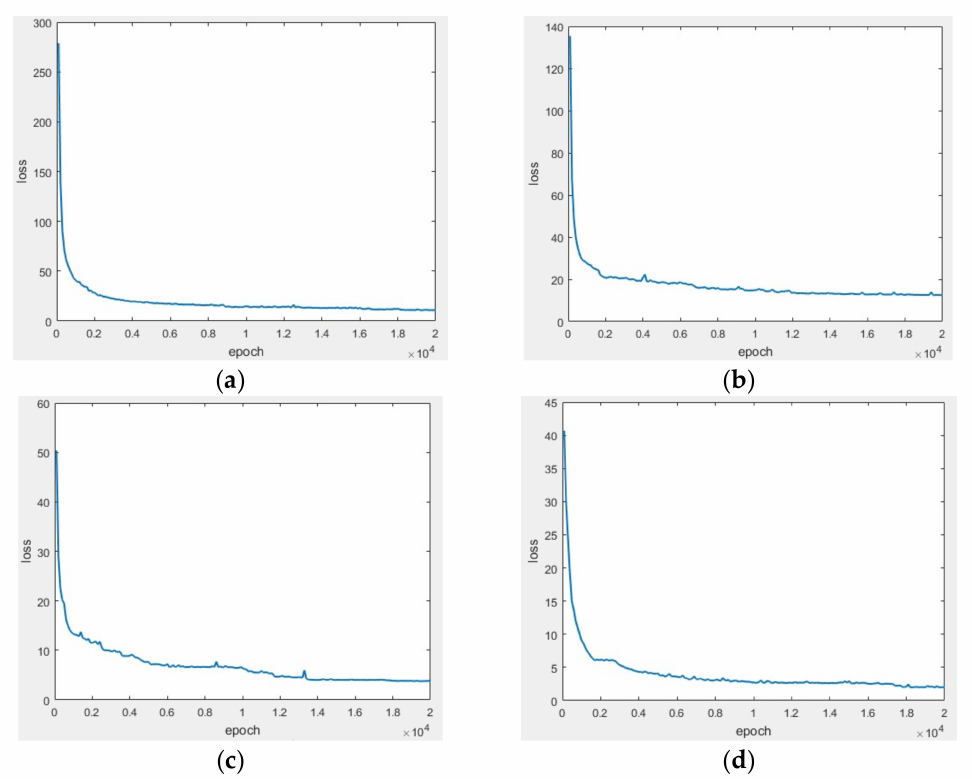
Figure A6. Convergence curves with training epochs. ( a )ORL, ( b )Yale, ( c )MSRCV1, ( d